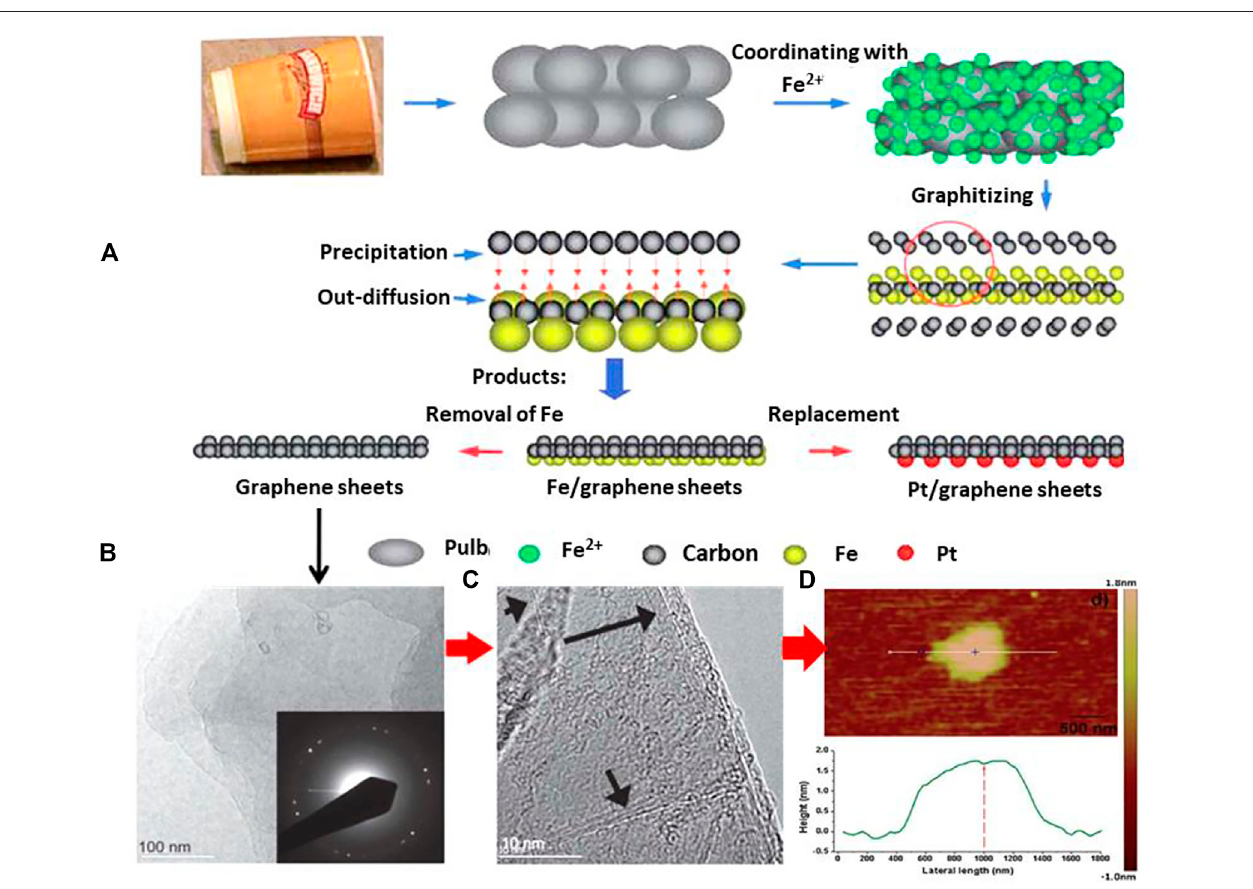
FIGURE7|(A) SynthesisofFe/graphenesheets,graphenesheets,andPt/graphenesheetsusingdisposablepapercups, (B) TEMimageofgraphenesheetswith theSAEDpatternininset, (C) thegraphene sheetsmainlycomposed offew-layerandmultilayergrapheneasobservedintheHRTEMimage, (D) theAFMimageandthe corresponding height pro fi le of the as-prepared graphene sheets. The fi gure is reprinted with permission from Zhao and Zhao 2013, Copyright 2013, Royal Society of Chemistry.